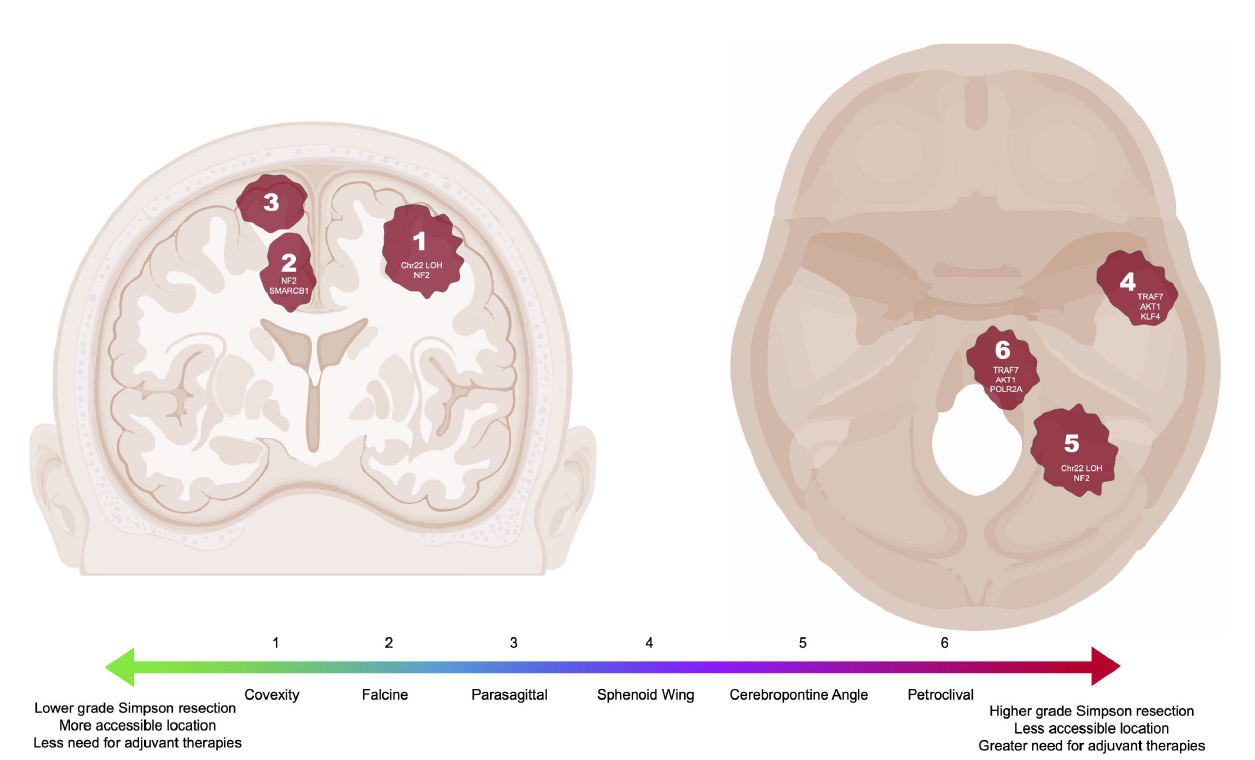
FIGURE 1 | Common intracranial locations of meningiomas highlighted in this review with associated DNA driver mutations or chromosomal loss (6, 14, 23, 24). Locations correlated to a generalized scale ranging from less (green) to more (red) complicated to resect and manage. Meningioma locations not pictured include clinoid, foramen magnum, cavernous sinus, suprasellar, and